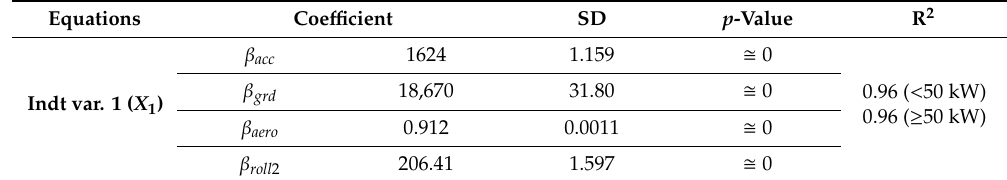
Table 3. Coe ffi cient calibration for Prius3 driving-power